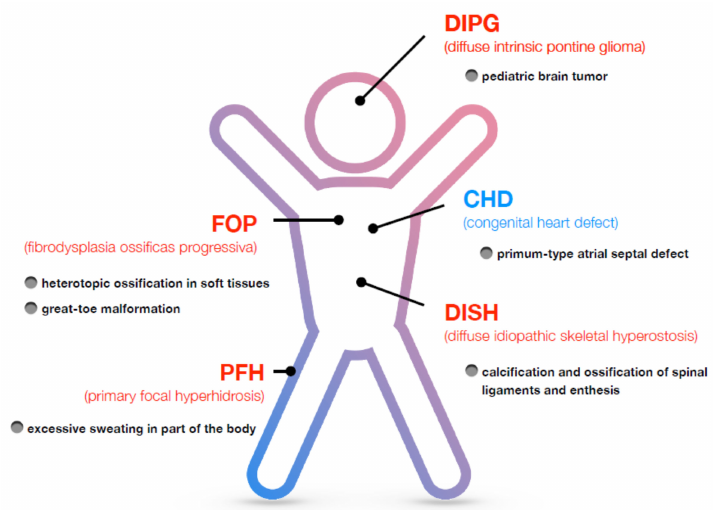
Figure 1. Disorders associated with ALK2/ACVR1. Five types of disorders reported to be associated with ALK2/ACVR1 are summarized, along with their major clinical features. Fibro-dysplasia ossifi- cans progressiva (FOP), diffuse intrinsic pontine glioma (DIPG), diffuse idiopathic skeletal hyperosto- sis (DISH), and primary focal hyperhidrosis (PFH) may be caused by overactivation of ALK2/ACVR1. In contrast, congenital heart defects (CHDs) are caused by suppression of ALK2/ACVR1 signaling. Please see details in the